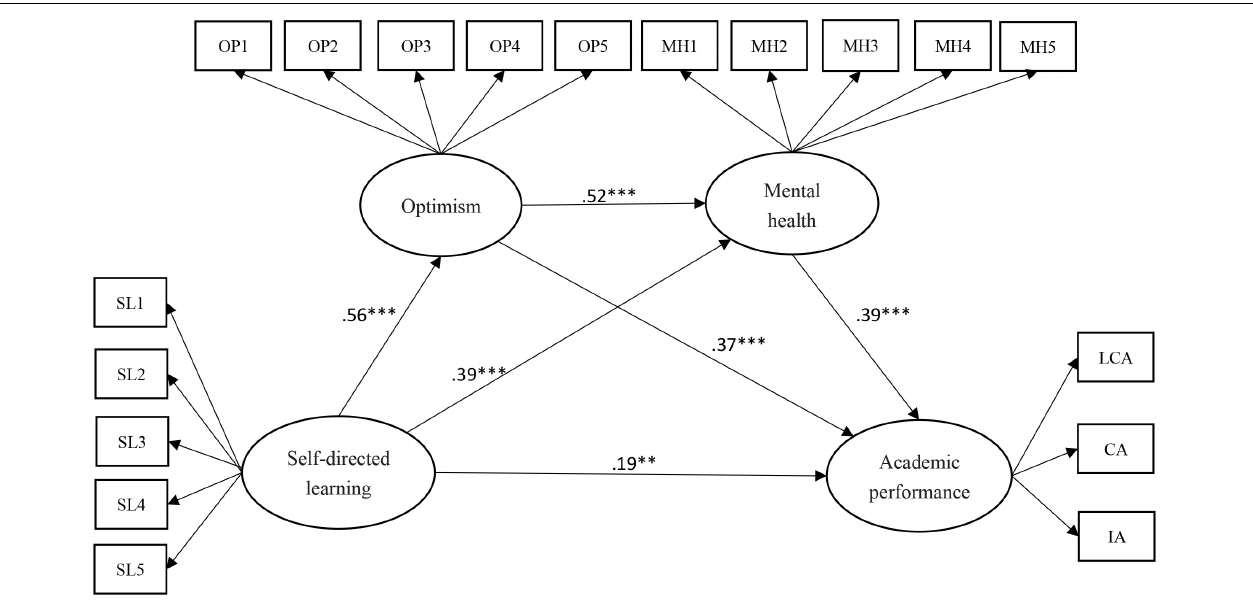
FIGURE 3 | Structural model. ** p < 0.01, *** p < 0.001.